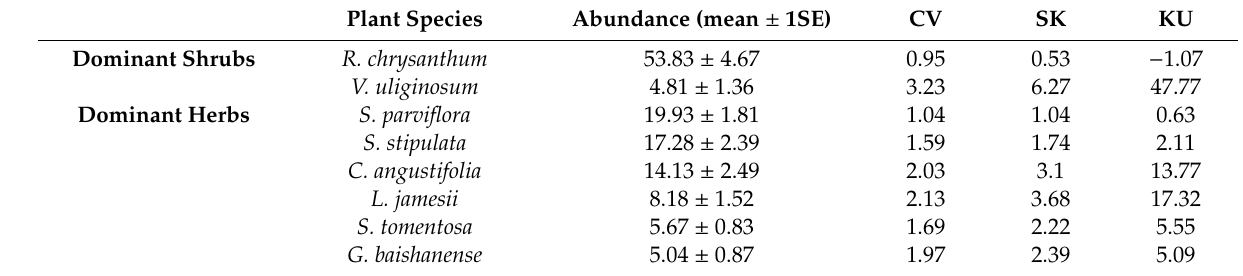
Table 2. Descriptive statistics of the abundance of the eight dominant species.